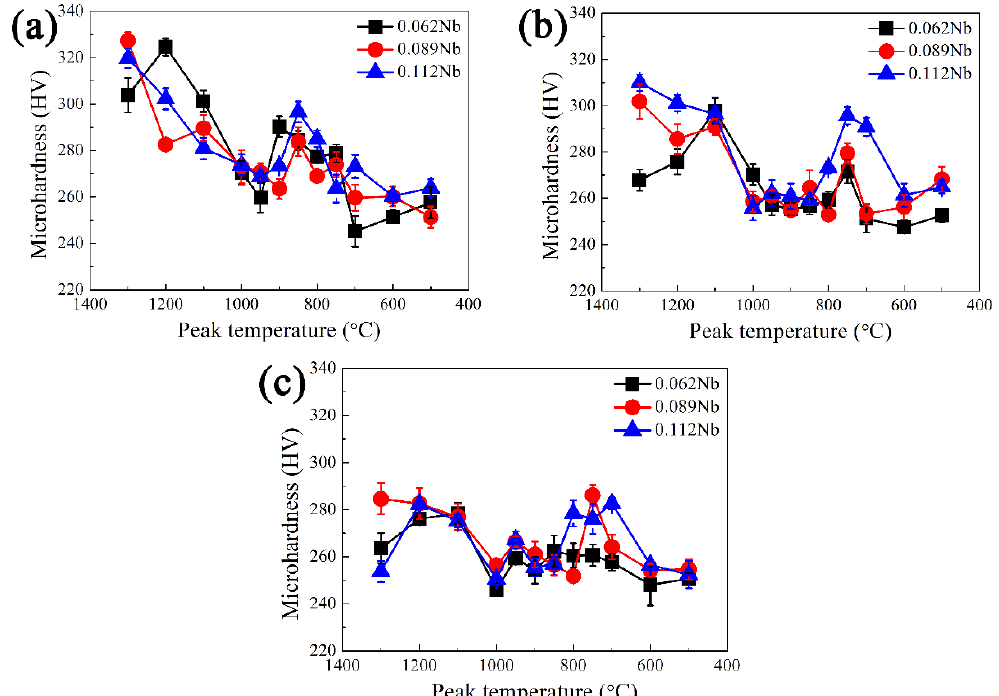
Figure 11. Microhardness of test steels under different Nb contents with ( a ) 10 kJ/cm, ( b ) 25 kJ/cm and ( c ) 30 kJ/cm heat inputs.